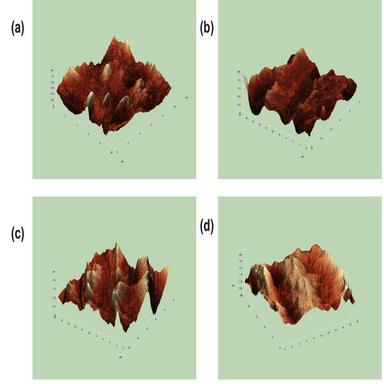
AFM images of (a) untreated (b) 3% alkali treated (c) 5% alkali treated (d) 7% alkali treated fiber.